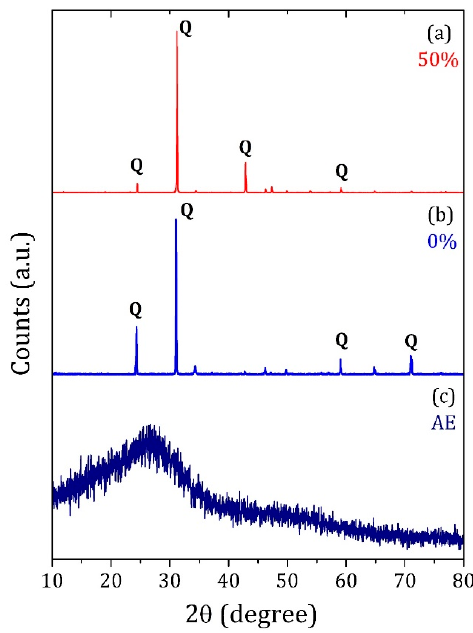
Figure 3. X-ray di ff raction pattern of the ( a ) PC / AE composite with 50 wt% AE, ( b ) PC sample, and Figure 3. X-ray diffraction pattern of the ( a ) PC/AE composite with 50 wt% AE, ( b ) PC ( c ) AE particles after thermal treatment at 250 ◦ C. sample, and ( c ) AE particles after thermal treatment at 250 °C.